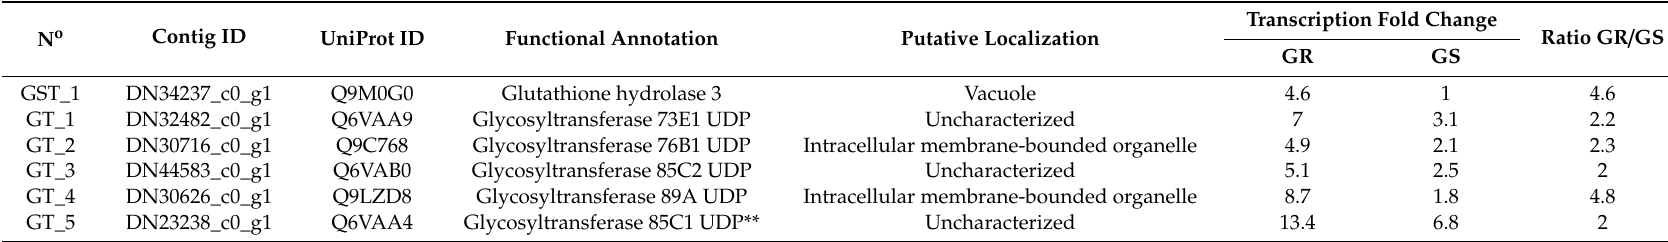
Table 3. Di ff erential expression of glutathione (GST) and glycosyltransferase (GT) genes via RNA-Seq analysis of glyphosate-resistant (GR) and -sensitive